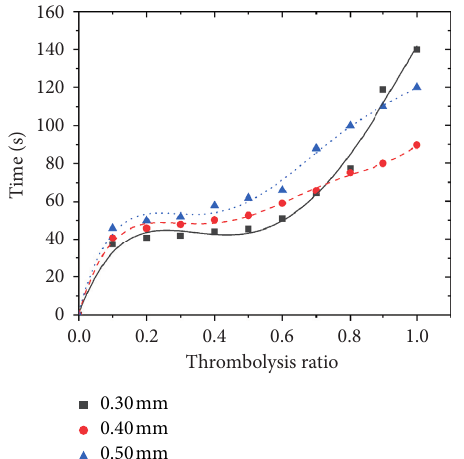
Figure 10: Thrombolysis time for different positions of 0.30mm, 0.40mm, and 0.50mm. Thrombolysis ratio of 1.0 denotes complete